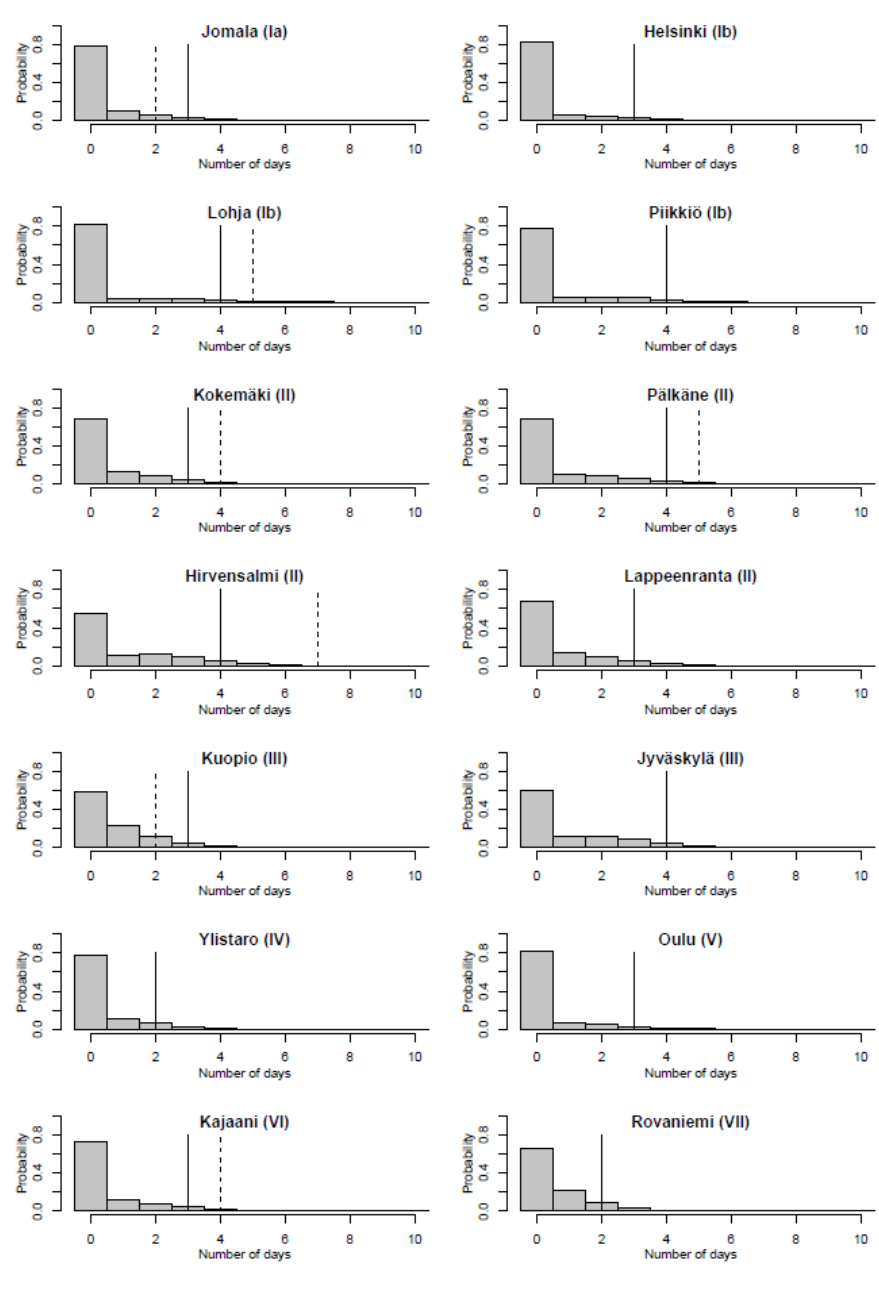
Fig. 2. The distribution of the number of “infections days” per year for the studied geographical locations for cultivar Pirja. The bars show the predictive probability distributions of “infection days”obtained with Bayesian analysis, and the solid lines indicate the respective upper bound of 95% HPD-interval (i.e. high - est posterior density interval). The broken lines indicate the highest number of “infection days” predicted for the years 1993 − 2012 by the Maryblyt analysis. (When the lines overlap, only the solid line is visible.) The plant growth zones of the locations are shown in